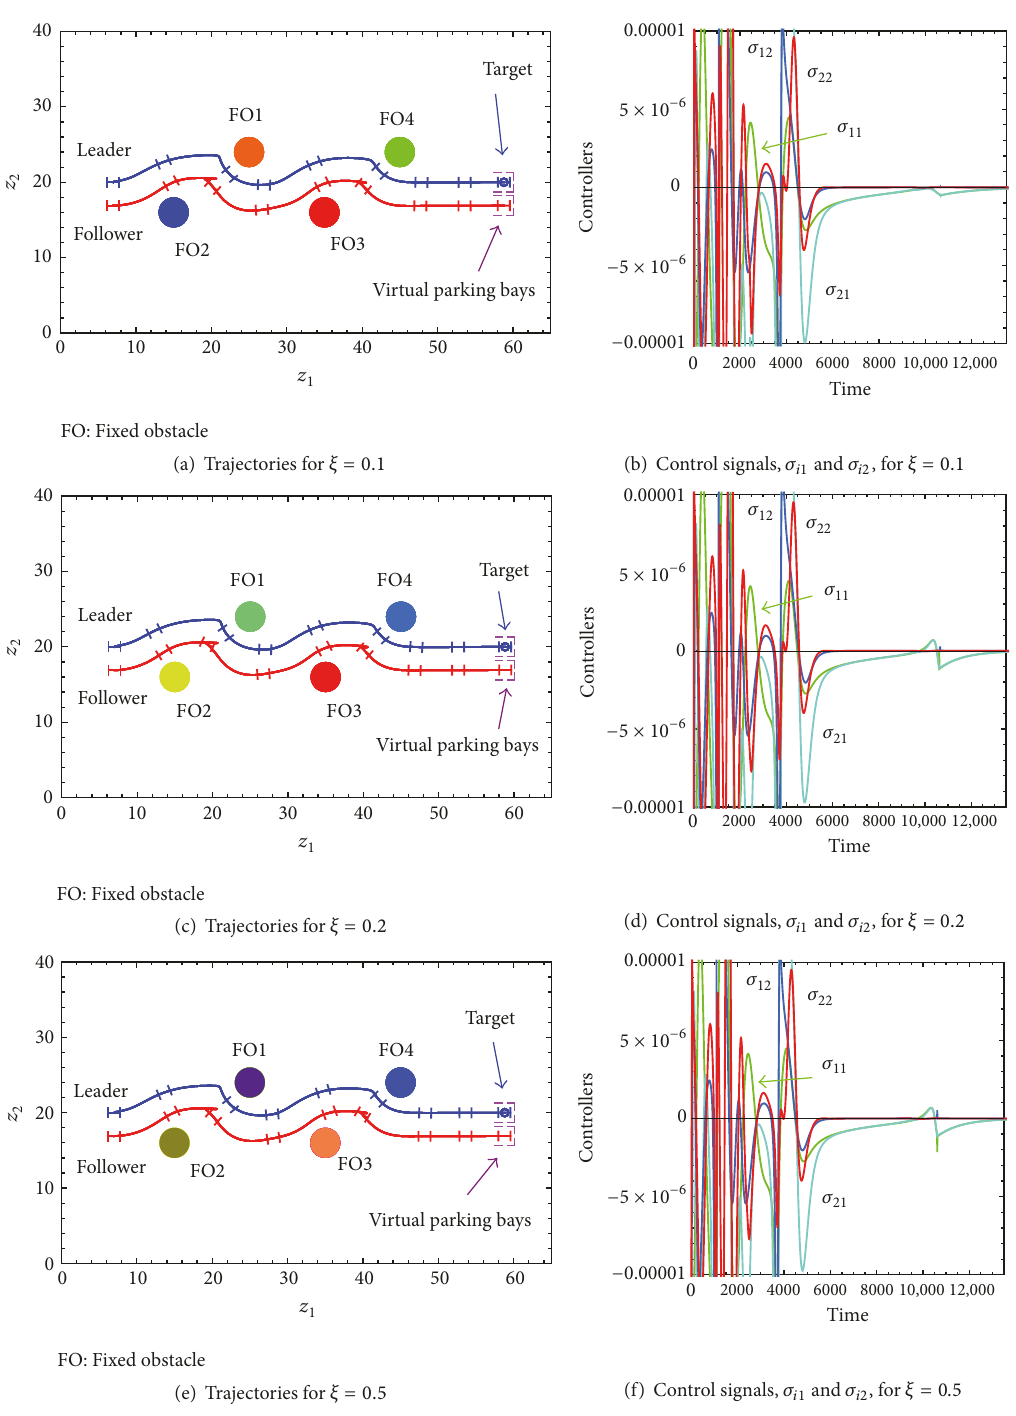
Figure 11: Trajectories of A 1 and A 2 and the evolution of control signals under various influences of